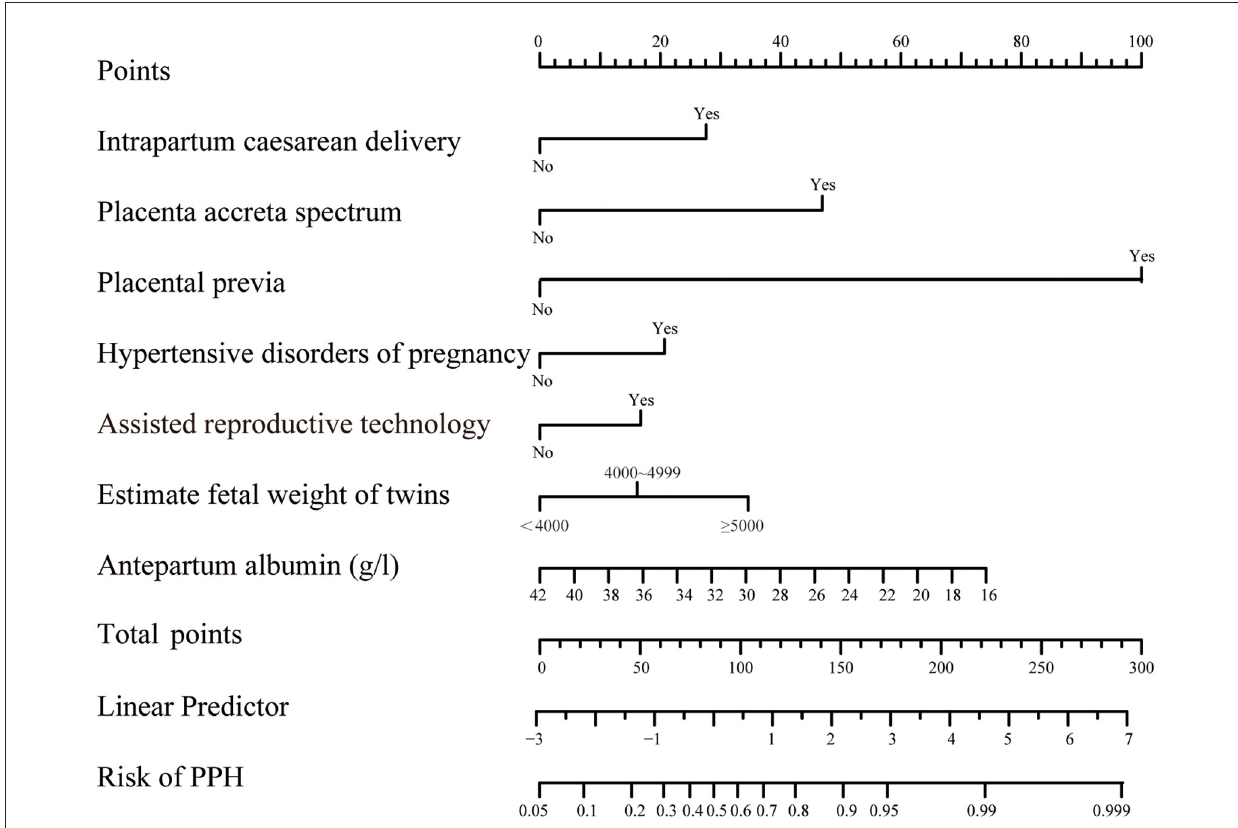
FIGURE2 Nomograms for twin pregnancies in PPH probability estimate. The score of each variable was obtained by drawing a vertical line from the corresponding value to the top point axis separately, and then, the cumulative point score for all the variables was matched to the corresponding risk of postpartum